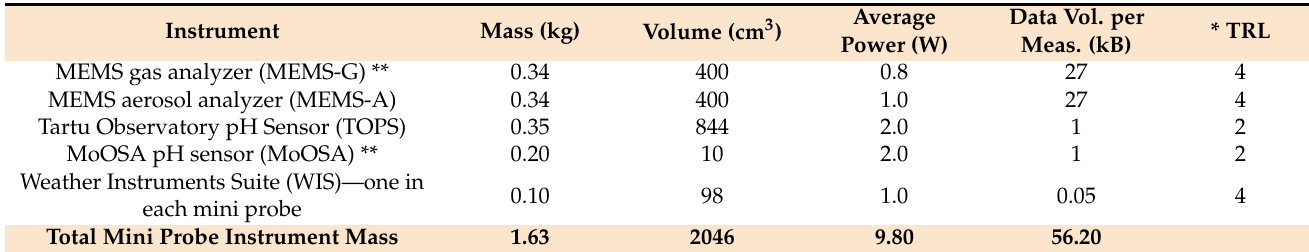
Table 5. Scientific instruments considered as payloads for the mini